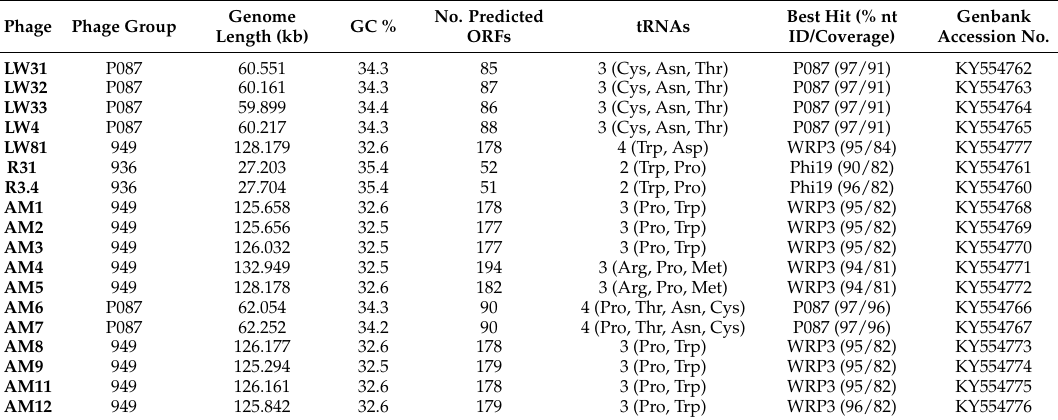
Table 2. Table 2. Genomic characteristics of sequenced phages in this